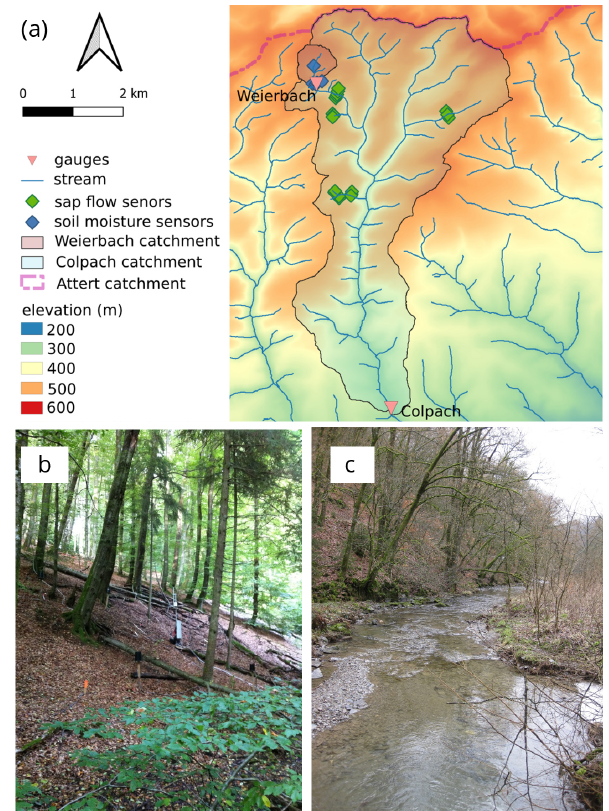
Figure 1. (a) Map of the Colpach and Weierbach catchments (lo- cation: northern Luxembourg) indicating the gauges, soil moisture, and sap flow sensors. Panel (b) is a picture of a typical forested hill- slope within the Colpach catchment with installed sap flow sensors, and (c) shows the Colpach River around 4km north of the gauging